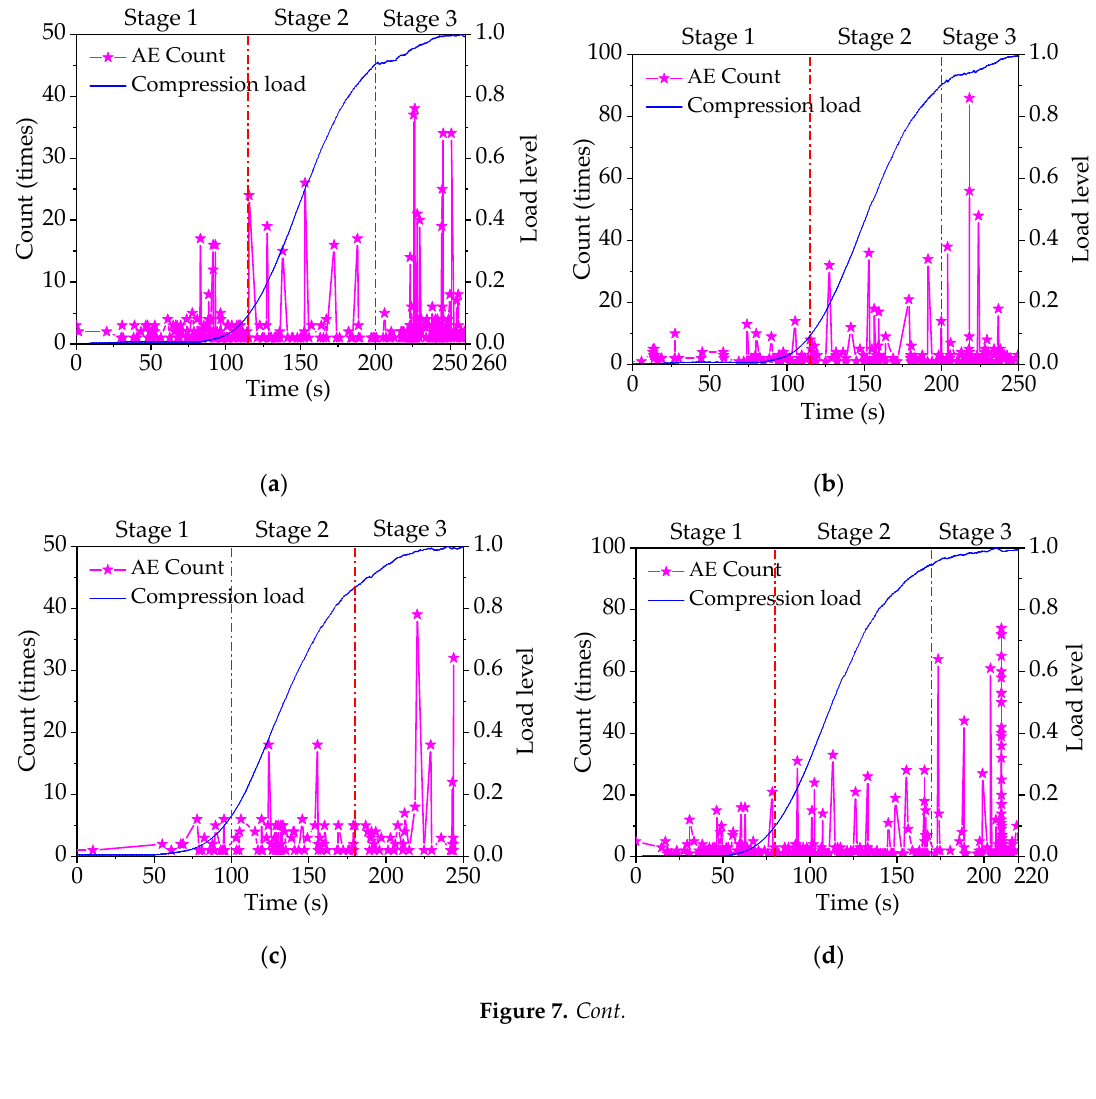
Figure 6. The AE amplitude and load level versus time during compression at 50 °C for SBS-modified asphalt mixture with basalt fiber under various freeze-thaw (F-T) cycles. ( a ) 0 F-T cycle; ( b ) 3 F-T cycles; ( c ) 6 F-T cycles; ( d ) 9 F-T cycles; ( e ) 12 F-T cycles; ( f ) 15 F-T cycles; ( g ) 18 F-T cycles; and ( h ) 21 F-T cycles.